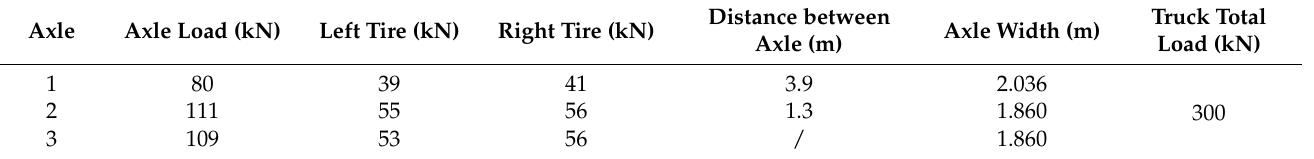
Table 2. Load Vehicle